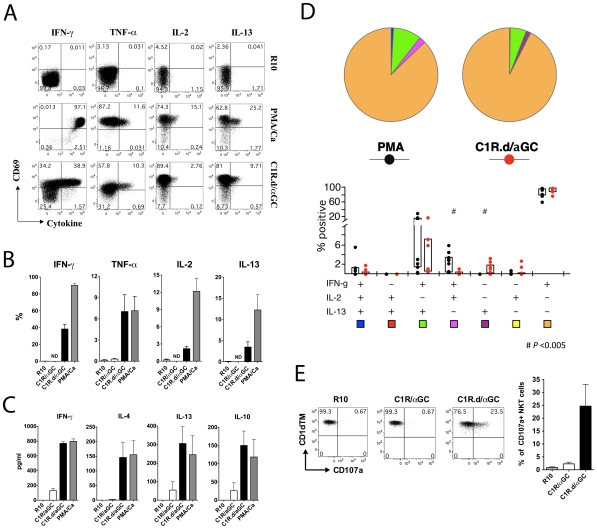
Th1 and Th2 cytokine production by sooty mangabey NKT clones.A) Intracellular cytokine staining of one representative NKT clone with antibodies against IFN-γ, TNF-α, IL-2, and IL-13 following 16 hours in vitro stimulation with PMA/Ca or the specific ligand α-GalCer presented on C1R.d cells (C1R.d/α-GC). Medium alone (R10) served as a negative control. Dot plots gated on NKT lymphocytes show intracellular expression of recent activation marker CD69 versus each cytokine with stimulation conditions denoted on the right of each panel. Numbers denote the % of NKT cells in each quadrant. B) Mean frequency of cytokine-positive NKT cells. Data on 9 NKT clones shown. Error bars denote SEM. ND: Not determined. C) Cytokine ELISA for IFN-γ, IL-4, IL-13, and IL-10 on culture supernatants collected at 24 hours post-stimulation. Mean and SEM of four clones shown. D) Cytokine profile of the NKT clones with regards to the concurrent production of IFN-γ, IL-2, and IL-13. Data on 9 NKT clones after 16 hours of stimulation shown. Pie charts (top panel) showing the proportion of one-, two-, and three-functional responses in cytokine-secreting 6B11+ cells. Bar charts (bottom panel) showing the mean proportion of responding cells for each of seven functional combinations. Boxes represent interquartile ranges. E) Representative dot plots (on the left) gated on NKT clones showing CD107a surface expression in CD1d/α-GalCer stimulated NKT lymphocytes in comparison to cells stimulated with C1R/α-GalCer or medium alone for 4 hours. Mean frequency of NKT clones degranulating after 4-hour stimulation (on the right). Data on surface upregulation of CD107a on four NKT cell clones shown. Error bars denote SEM.